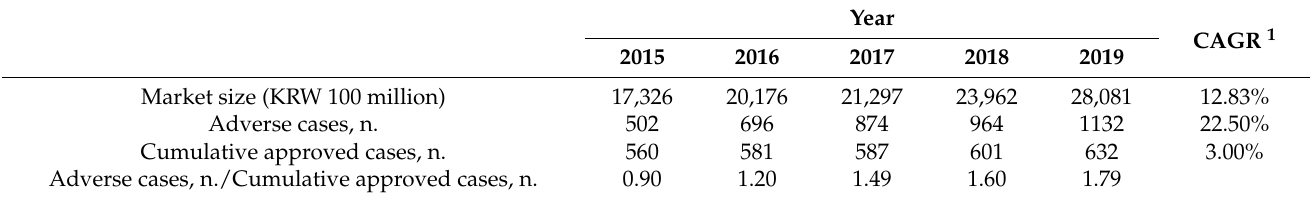
Table 2. Market size and number of approved cases compared to adverse cases of functional health foods in